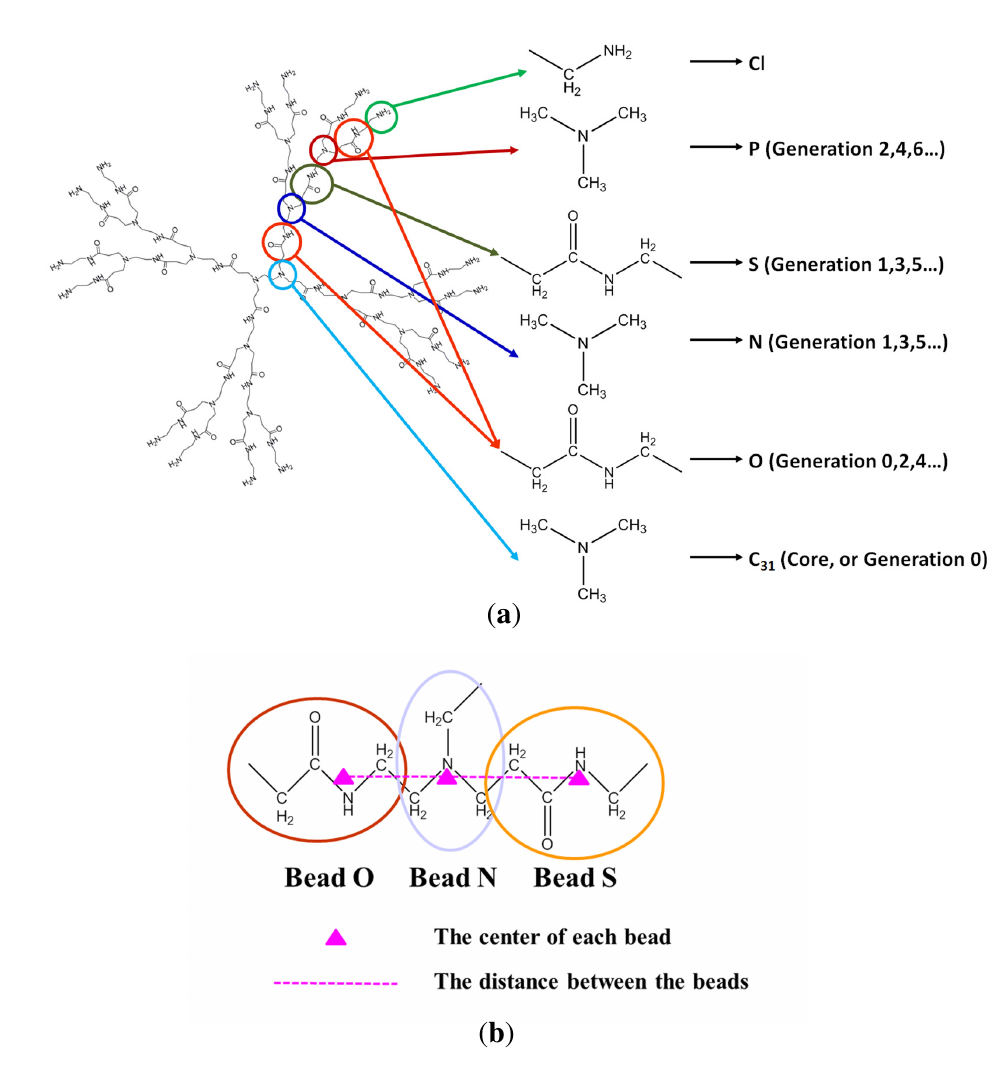
Figure 5. ( a ) Mapping of dendrimer PAMAM segments into coarse-grained beads; ( b ) The same segment in PAMAM has different bond lengths and we apply special protocol to label each segment. The distance between the center of beads O and N is different from the distance between the center of beads N and S, although beads O and S represent exactly the same segment (-CH2-CO-NH-CH2). Reprinted with permission from [89]. Copyright 2009 by the American Institute of